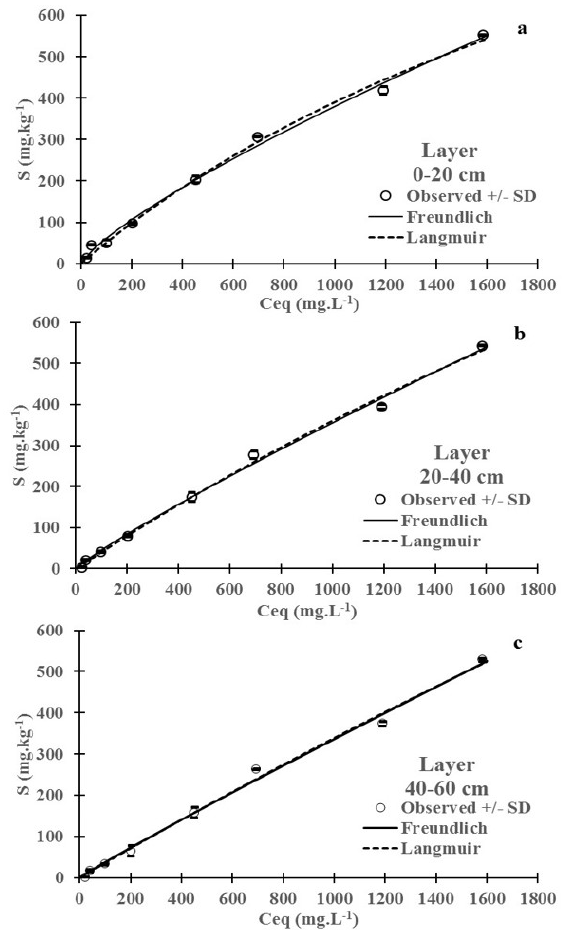
Figure 3 - Experimental isotherms (mean of three replicates and standard deviations), fitted by the Freundlich and Langmuir models for the soil layers of a ) 0-20, b ) 20-40 and c ) 40-60